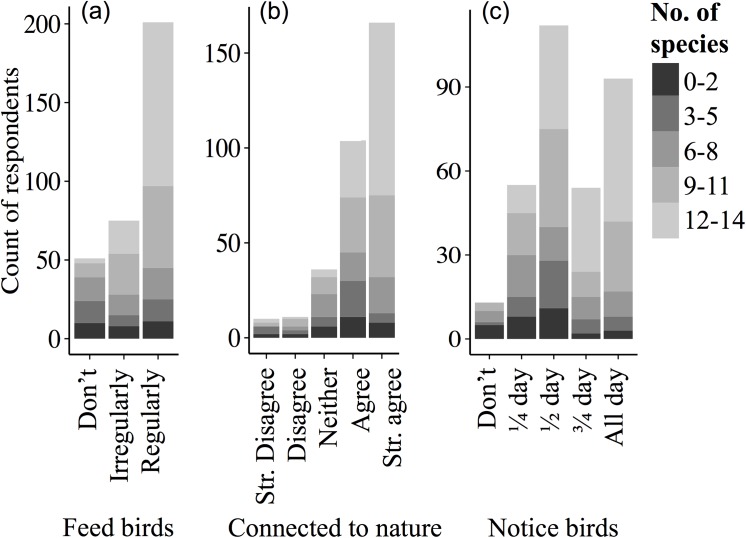
The relationship between the number of species that a person could name and (a) how regularly they fed birds, (b) how they agreed with the statement ‘I feel connected to nature when I watch birds in my garden’ (Strongly disagree “Str. disagree” to strongly agree “Str. Agree”), and (c) what proportion of the day they notice birds.The number of species that a respondent could name is also shown: 0–2, black; 3–5, dark grey; 6–8, medium grey; 9–11, medium light grey; 12–14, light grey.